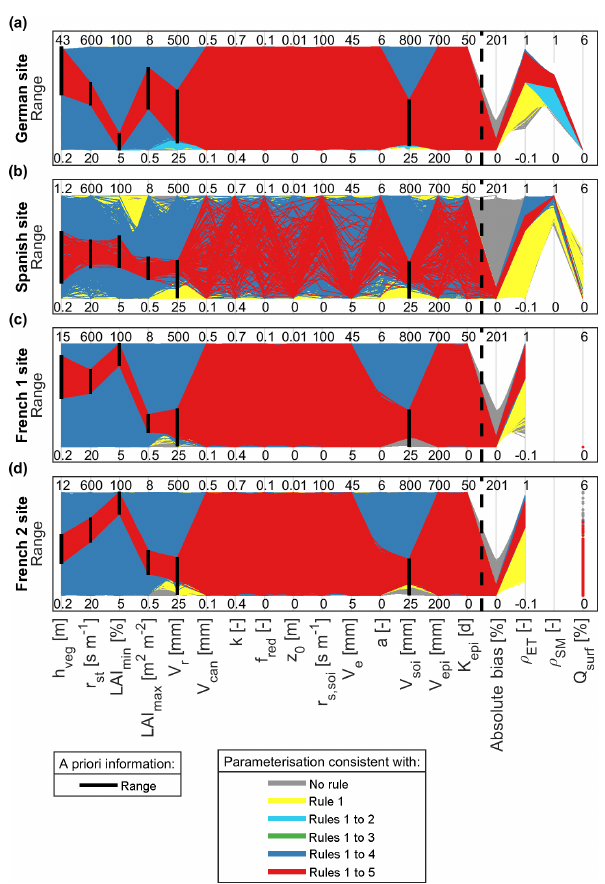
Figure 4. Parallel coordinate plots representing V2Karst be- havioural parameterisations, and their corresponding simulated out- put values, identified when sequentially applying the five soft rules defined in Sect. 4.1 at (a) the German site, (b) the Spanish site, (c) the French 1 site and (d) the French 2 site. Parameters are de- fined in Table 1. The bias absolute mean error between observed and simulated total actual ET (rule 1), the ρ ET correlation coeffi- cient between observed and the simulated total actual ET (rule 2), the ρ SM correlation coefficient between observed and simulated soil moisture (rule 3) and the Q surf surface runoff (rule 4) are displayed on the right of the figure. Rule 5 corresponds to application of a priori information on parameter ranges (black vertical bars).